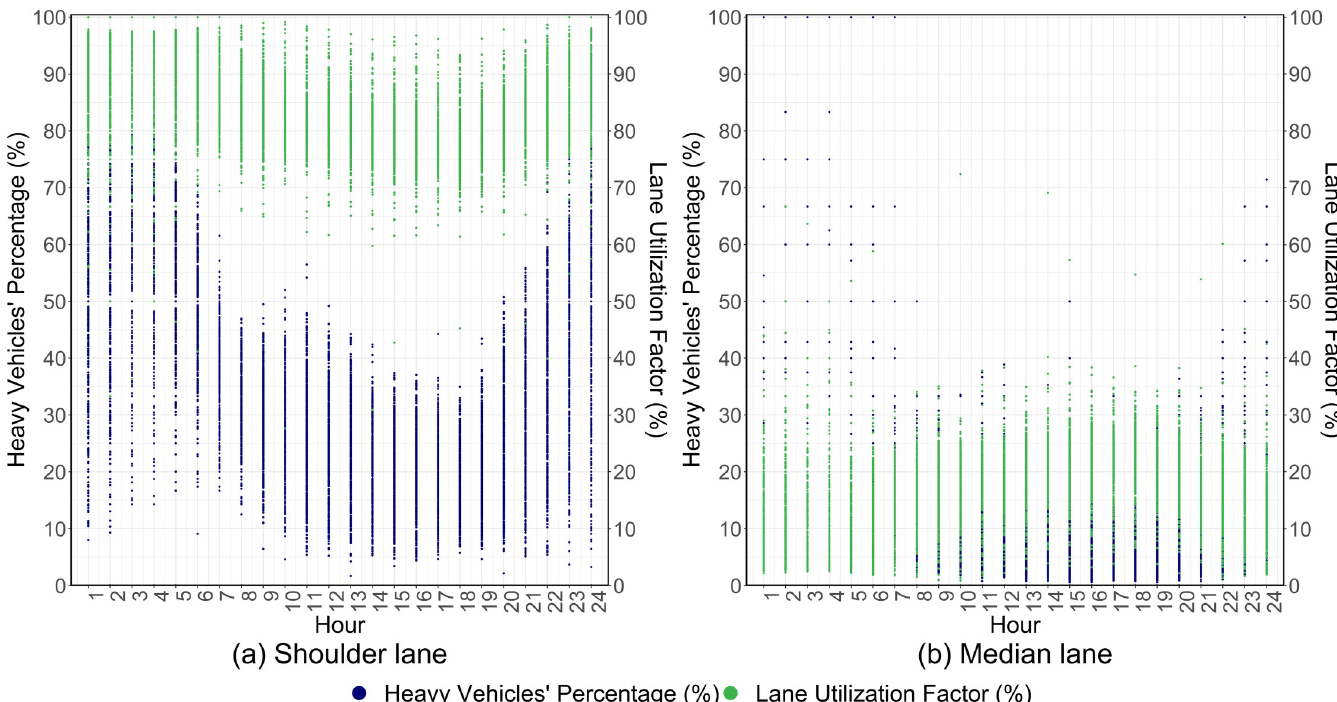
expressed in terms of the proportion of hourly vehicular flow of each lane to the respective total hourly vehicular flow of the eastbound direction. According to Fig 4, a substantial portion of the hourly vehicular flow in the shoulder lane constitutes of heavy vehicles, especially